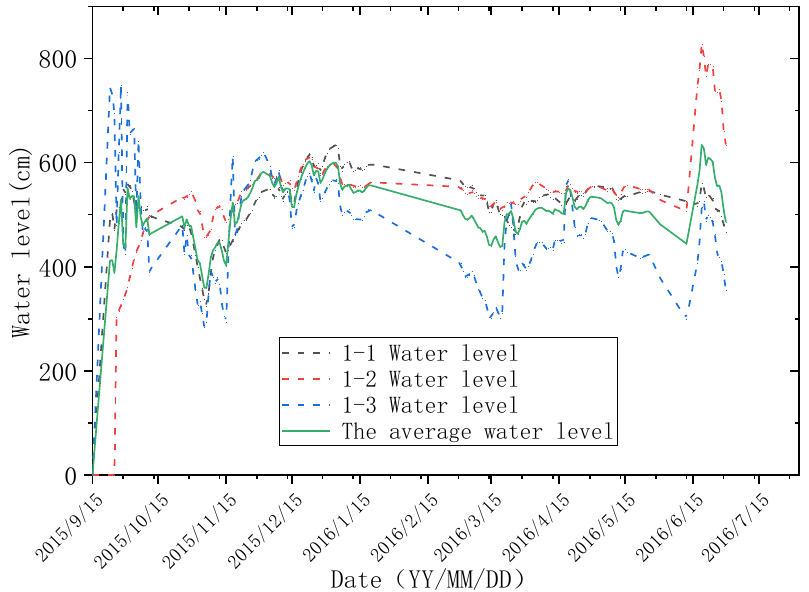
Figure 4. Variation in water level at different points on the same line of a rare earth slope with time.